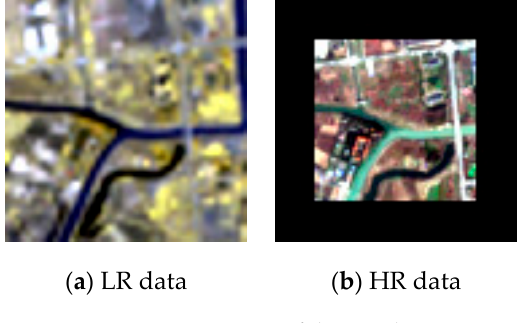
Figure 5. Coverage of the test data.